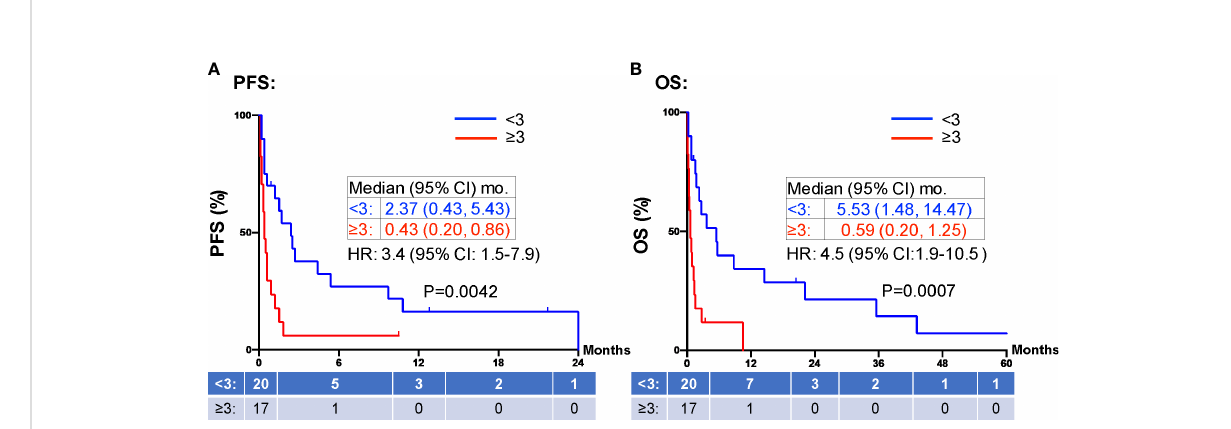
FIGURE 3 PFS and OS strati fi ed by comorbidities. Patients with greater than 3 comorbid conditions ( ≥ 3 red) were associated with shorter PFS (A) and OS (B) compared to those patients with fewer than 3 comorbid conditions (<3, blue). Groups were compared using the log-rank test. Tick marks indicate censored data. P<0.05 for statistical signi fi cance. PFS, progression free survival; OS, overall